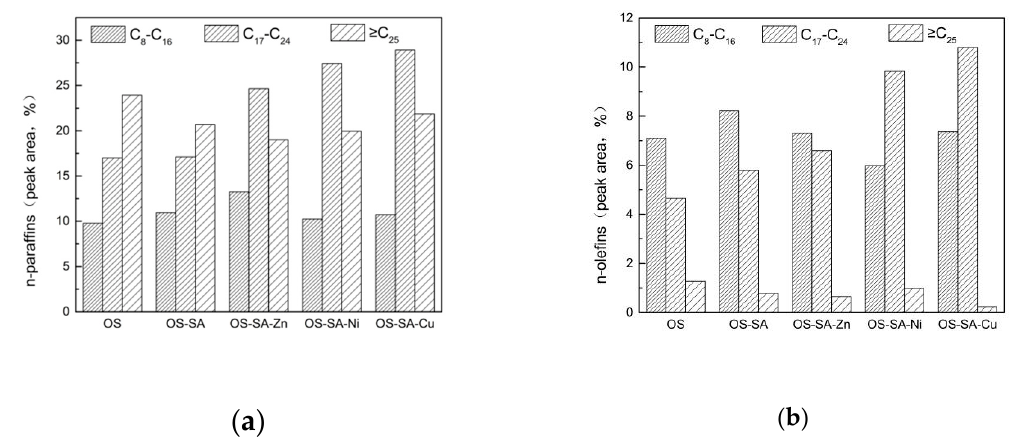
Figure 9. Distribution of ( a ) n-paraffins and ( b ) n-olefins within shale oil.